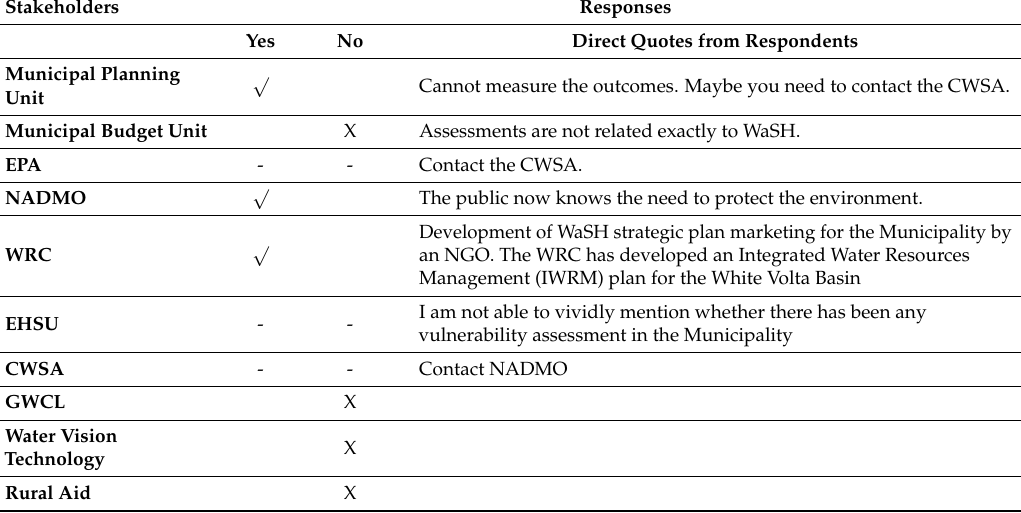
Table 4. Awareness of stakeholders regarding vulnerability assessments of climate change and WaSH in the